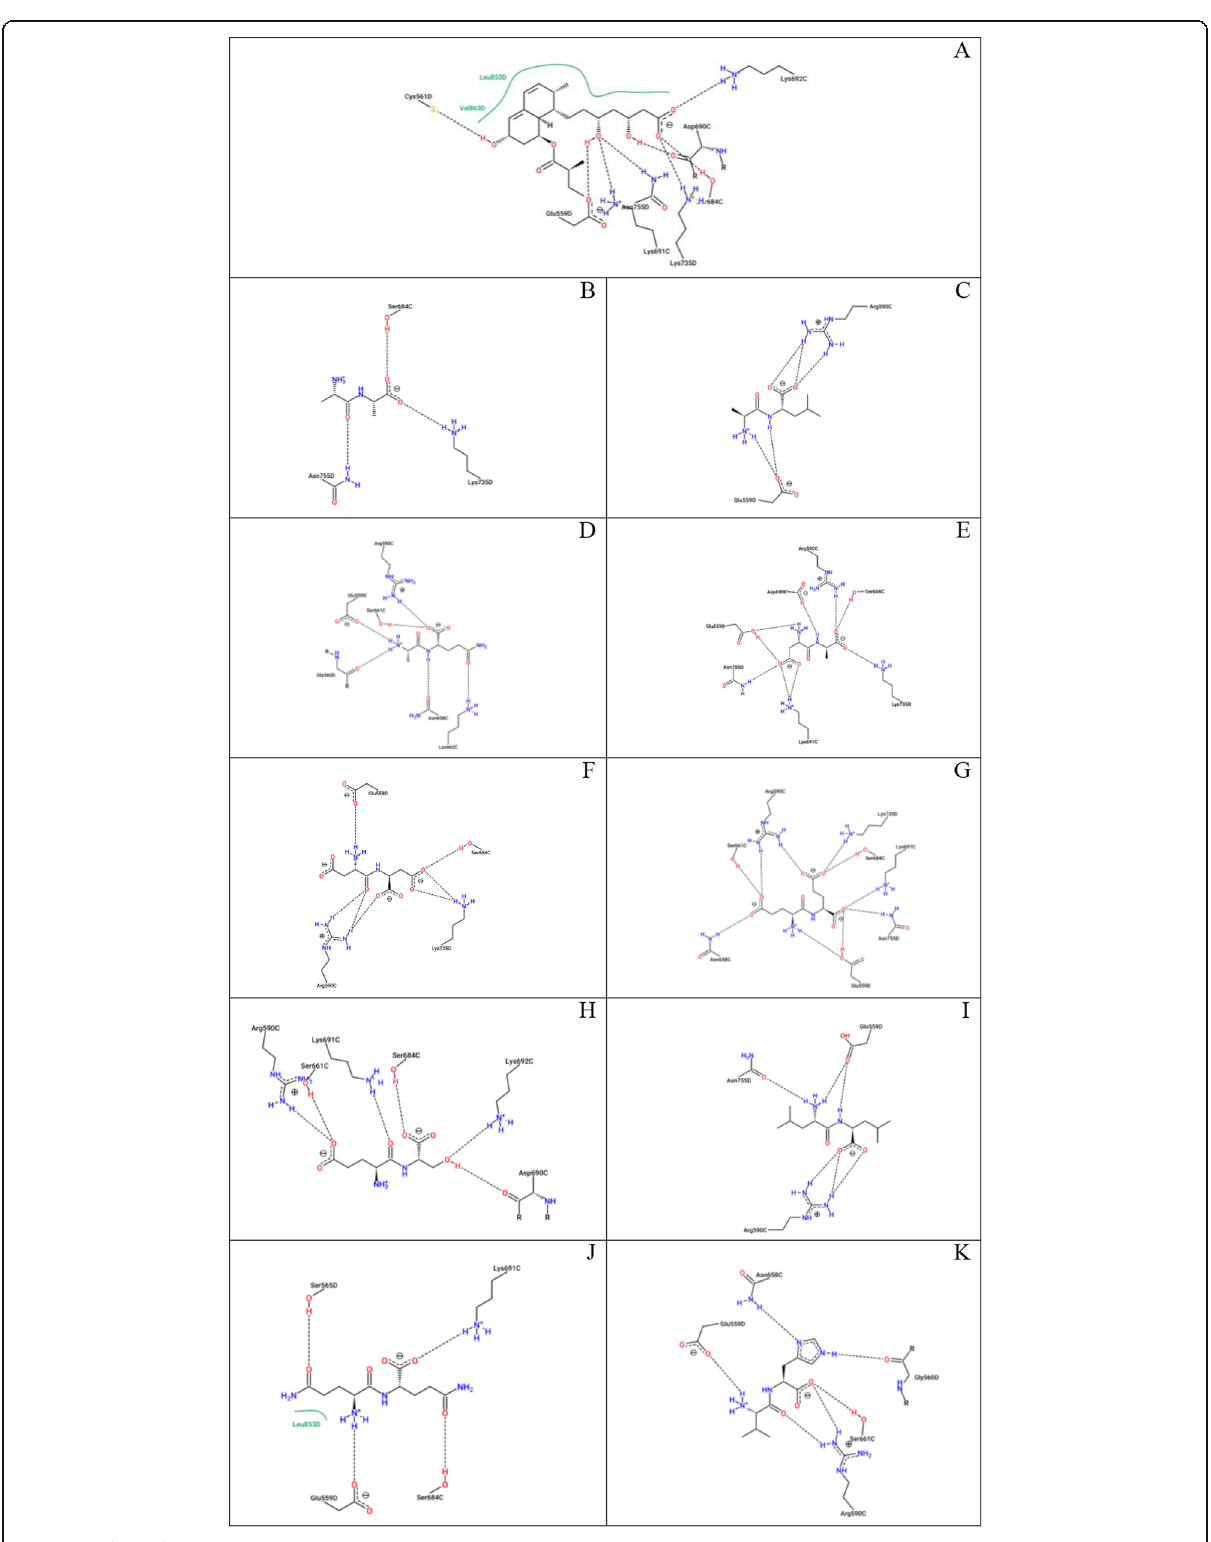
Fig. 3 (See legend on next